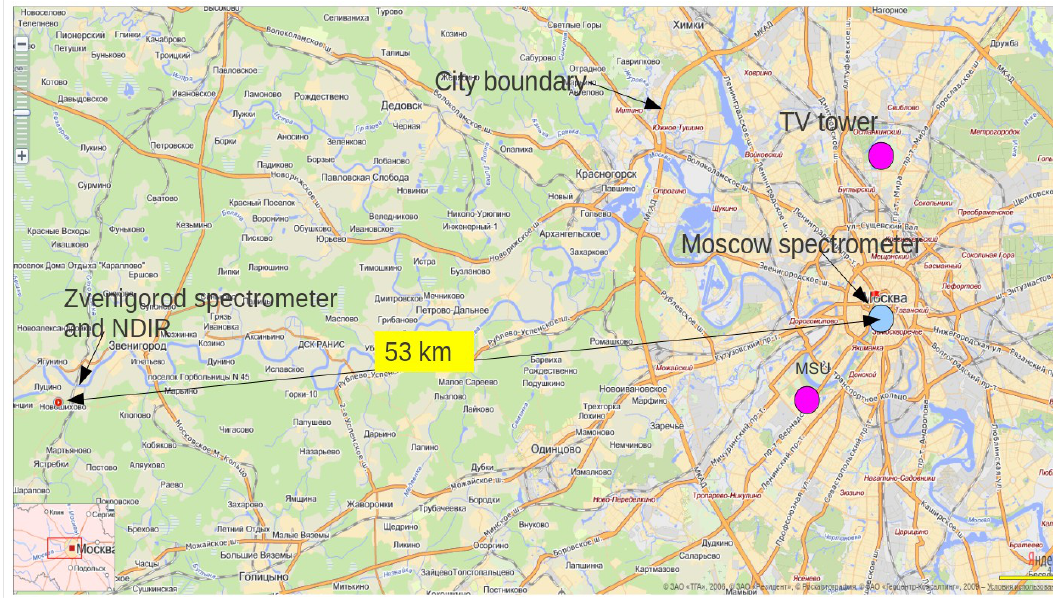
Fig. 1. Moscow, Russia, locations of ground-based